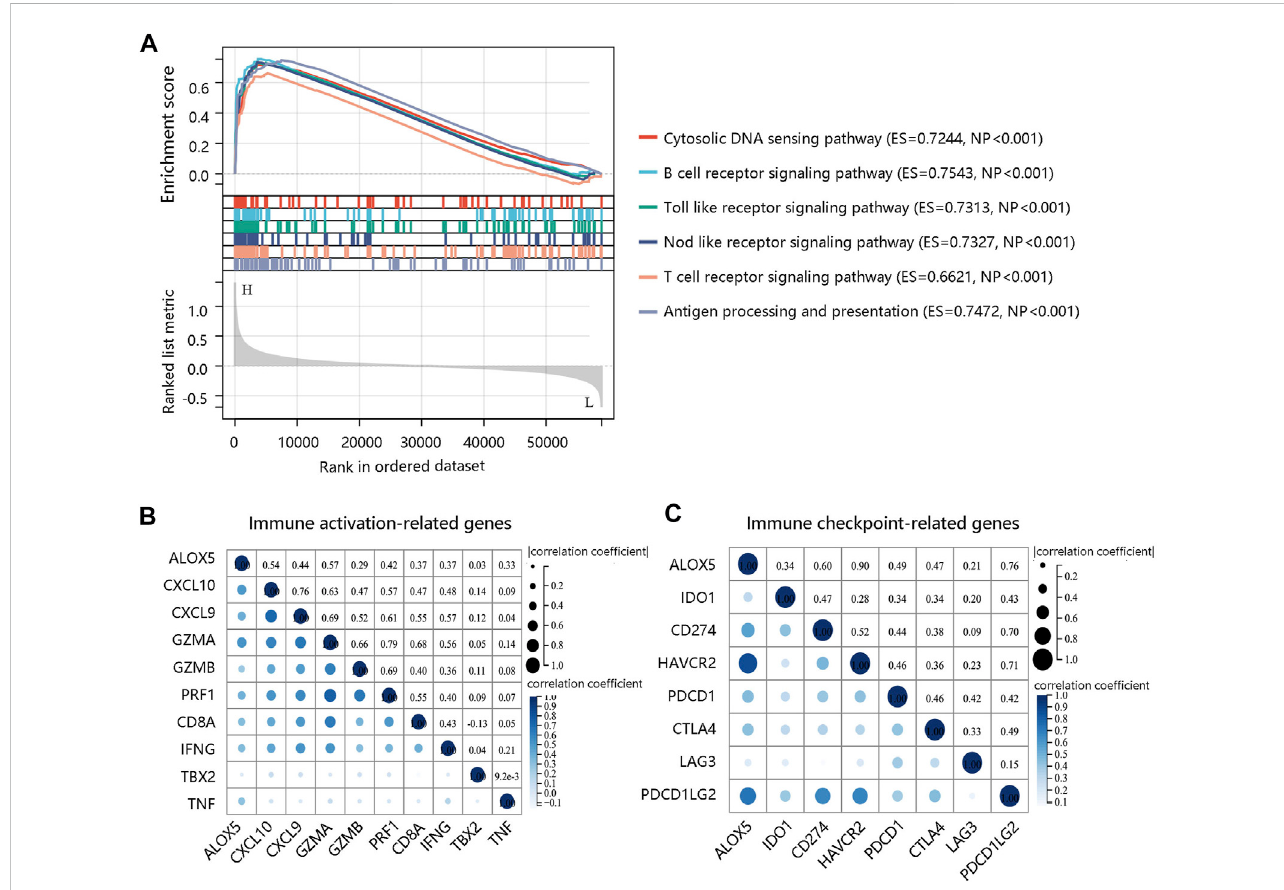
FIGURE 11 Molecular characteristics of ALOX5. (A) GSEA enrichment showing the relative enriched pathways in high ALOX5 expression group. (B) Correlations between ALOX5 and immune activation-related genes. (C) Correlations between ALOX5 and immune checkpoint-related